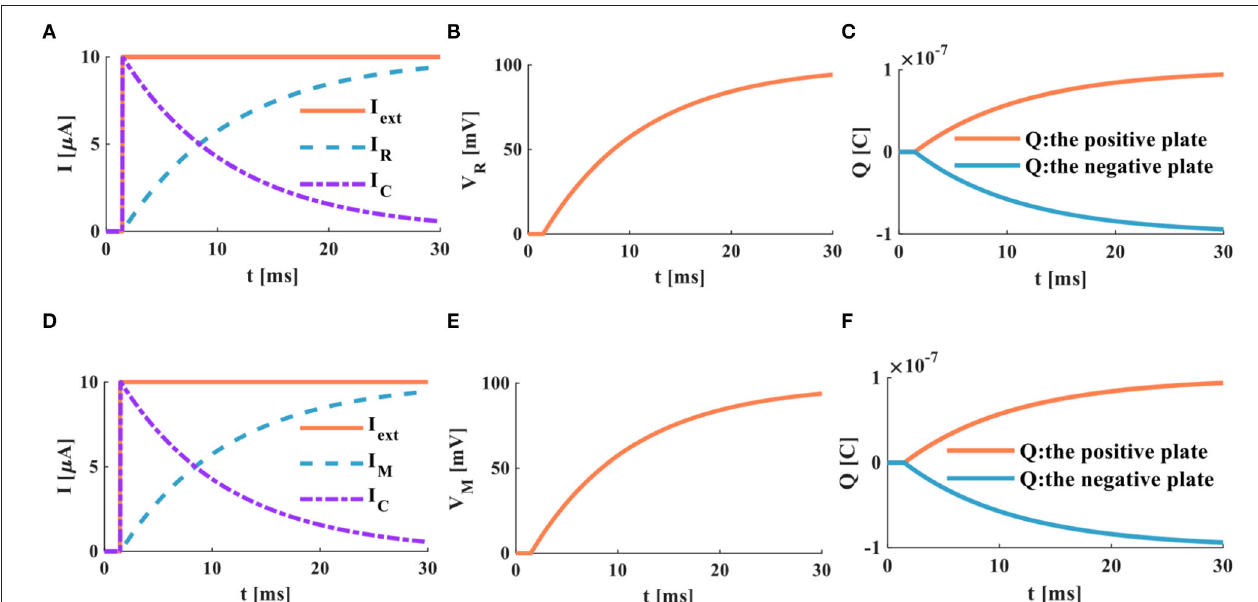
FIGURE 7 | The step current acts on the RC and MC neuron circuits, (A) the current flows through the resistor R and the capacitor C, (B) the membrane potential of the RC circuit, (C) the charges on the positive and negative plates in the RC circuit, (D) the current flows through the memristor M and the capacitor C, (E) the membrane potential of the MC circuit, (F) the charges on the positive and negative plates in the MC circuit.